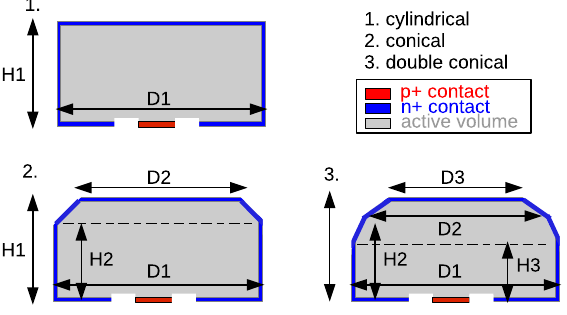
Fig. 2 Gerda Phase II BEGe diodes are either (1) cylindrical, (2) single-conical, or (3) double-conical. Overall heights are denoted with H1, while corner heights with H2 and H3. The overall diameter is dis- tinguished from corner diameters by D1 vs. D2,